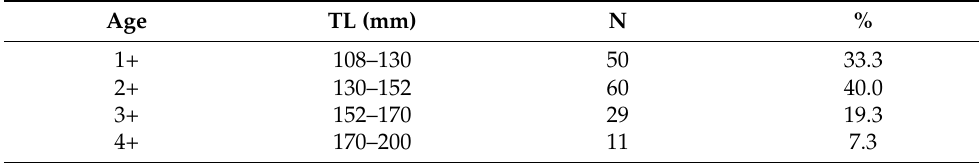
Table 5. Total length (TL) and groups of 150 specimens of S. scriba